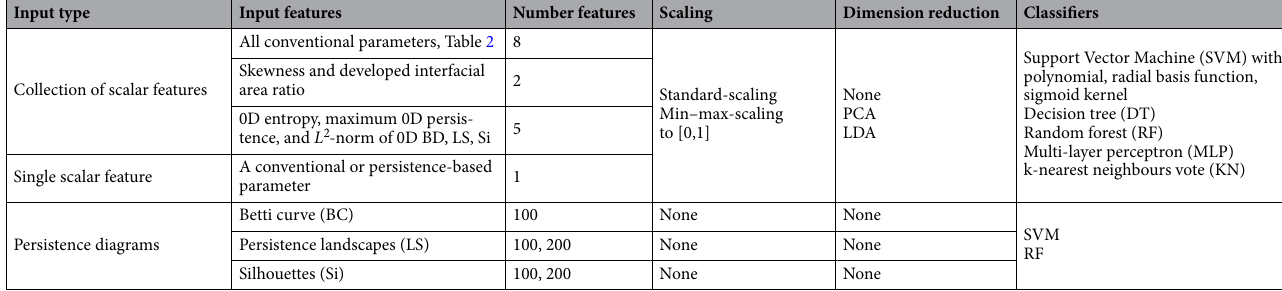
Table 4. Classification pipeline for different inputs.